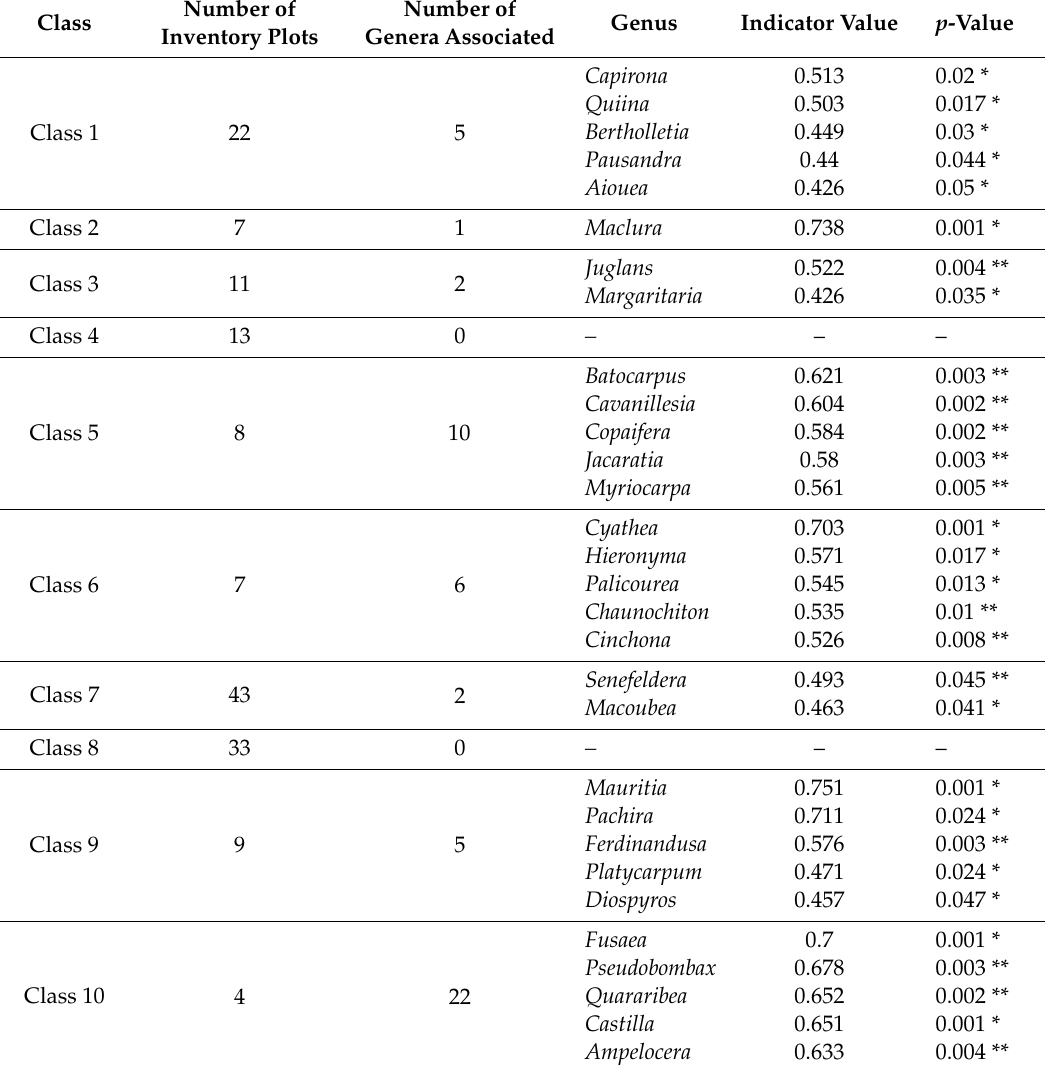
Table 3. Indicator analysis of 463 genera in relation to the classification of the floristic composition of trees in Peruvian Amazonia (see Figure